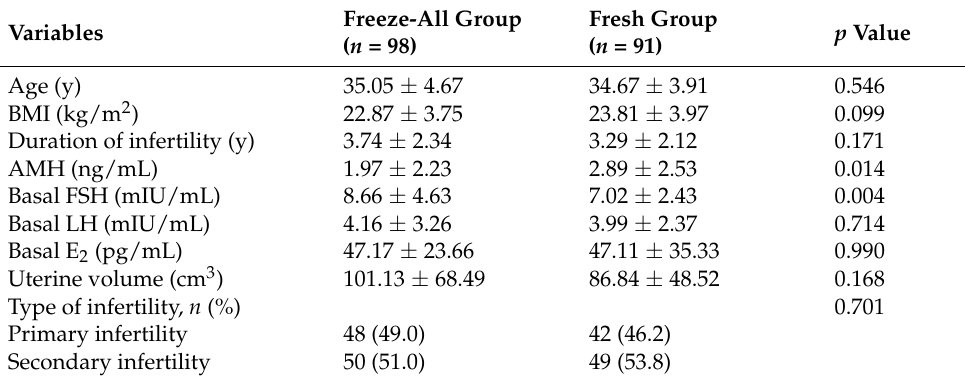
Table 1. Baseline characteristics and clinical features of patients in the two